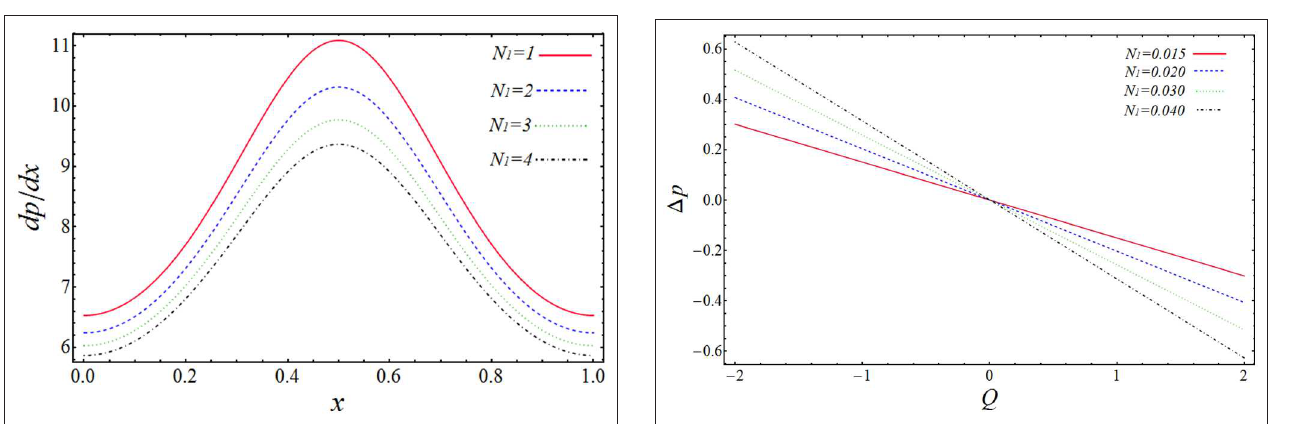
FIGURE 7 | Change of pressure gradient for N 1 when Q = 1, φ = 0.1, k 1 = 1, B = 0.01, C = 0.12.